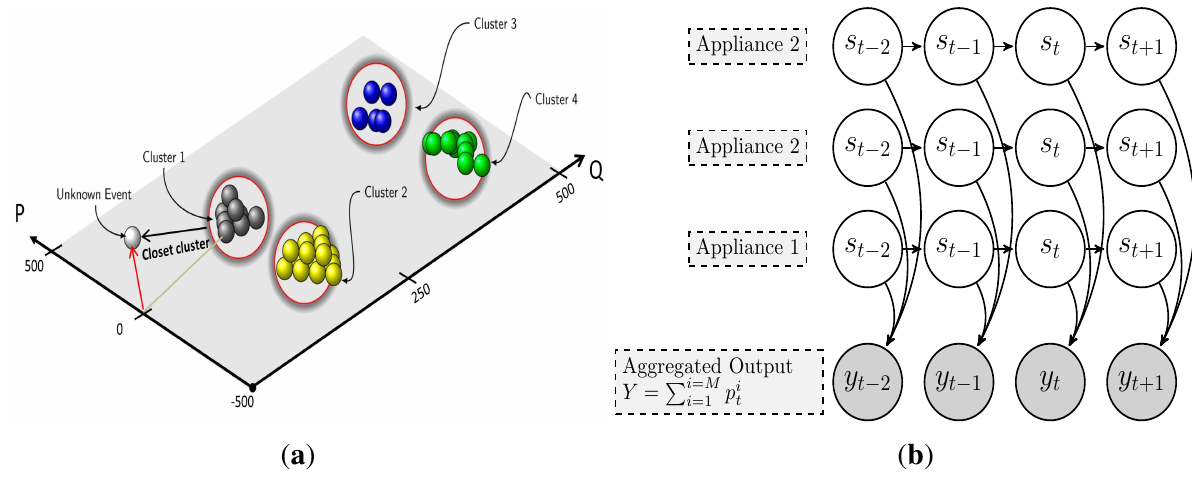
Figure 5. ( a ) MP algorithm tries to match the unknown event with the closest possible source; ( b ) To define a combined load model, appliance HMM’s are arranged in a specialized structure to form a Factorial